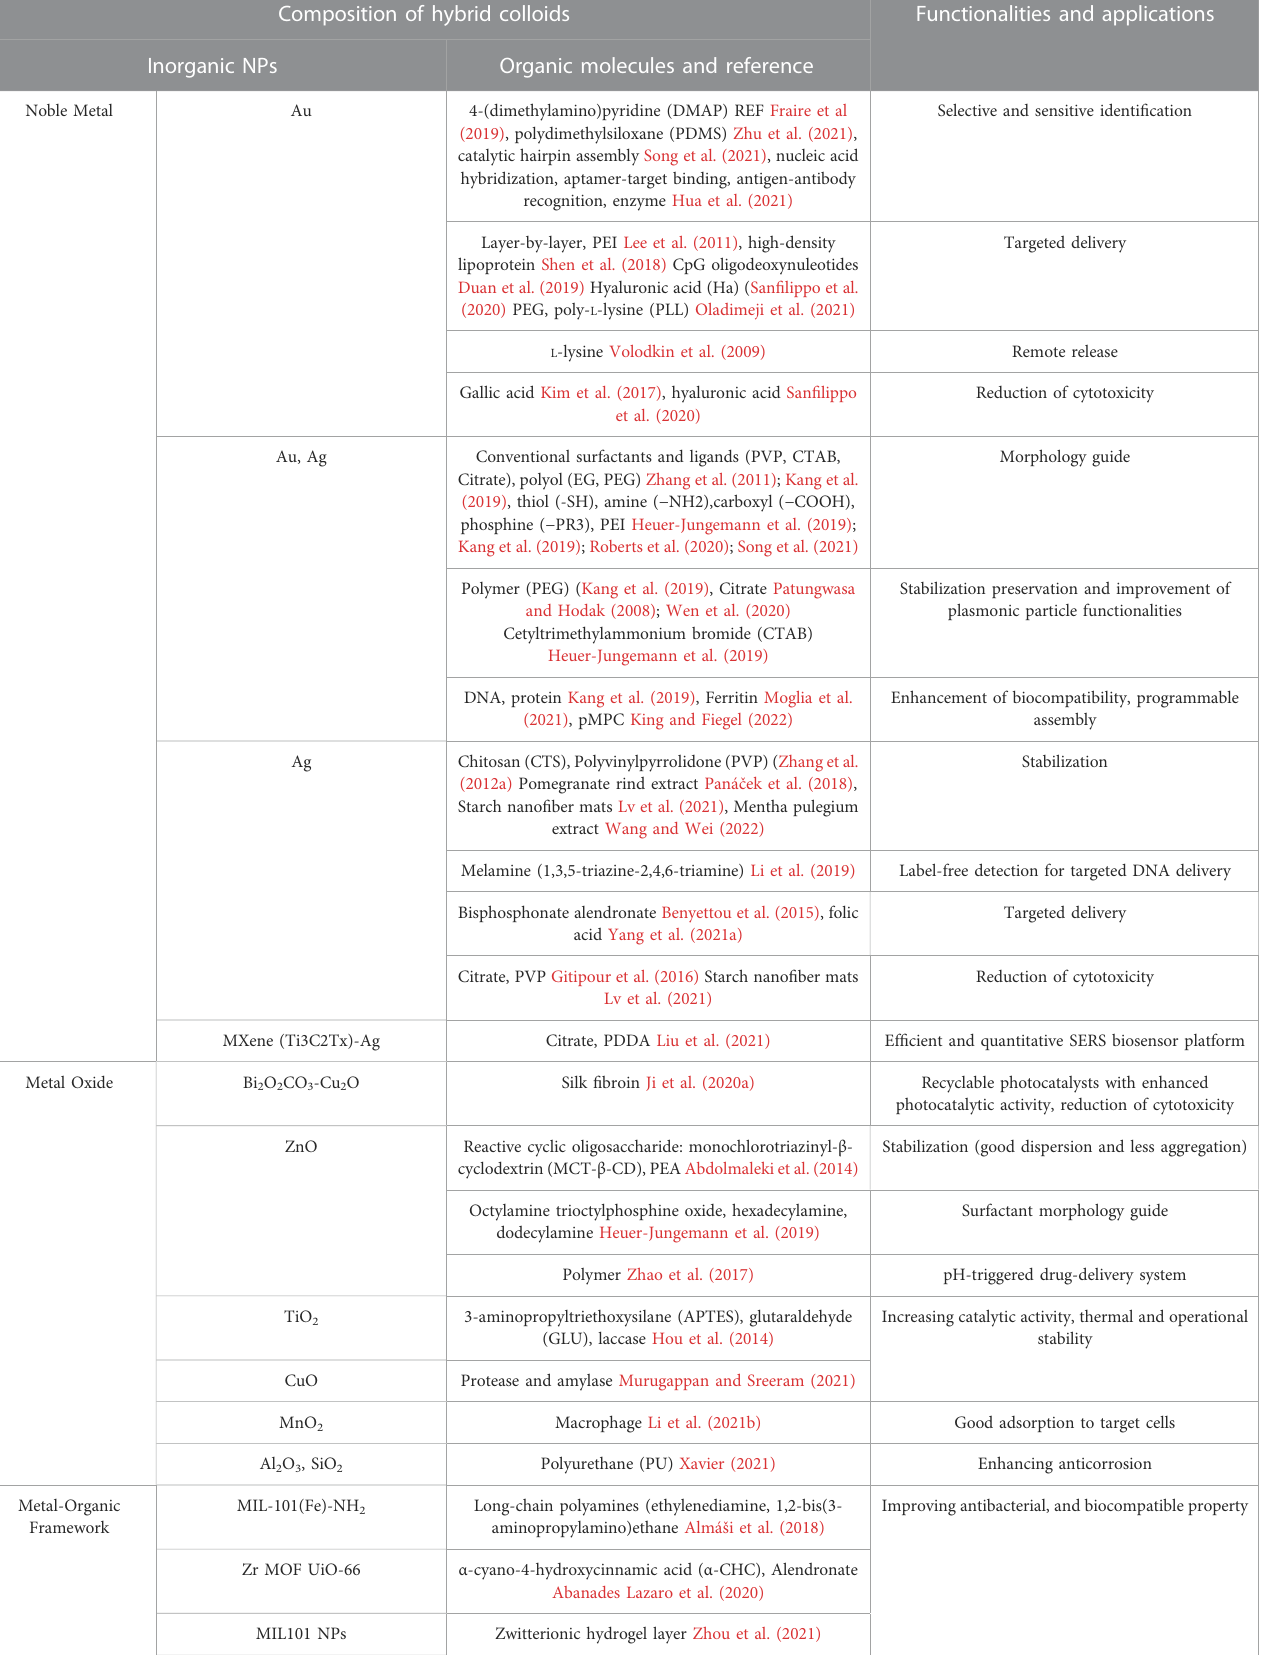
TABLE 1 The overview of the studies of hybrid organics-on-inorganics colloidal and their composition,